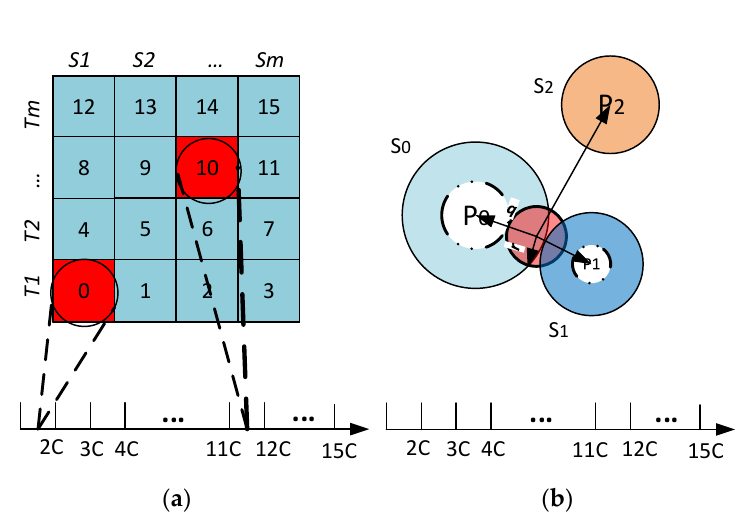
Figure 4. ( a ) Data mapping; and ( b ) range query example.